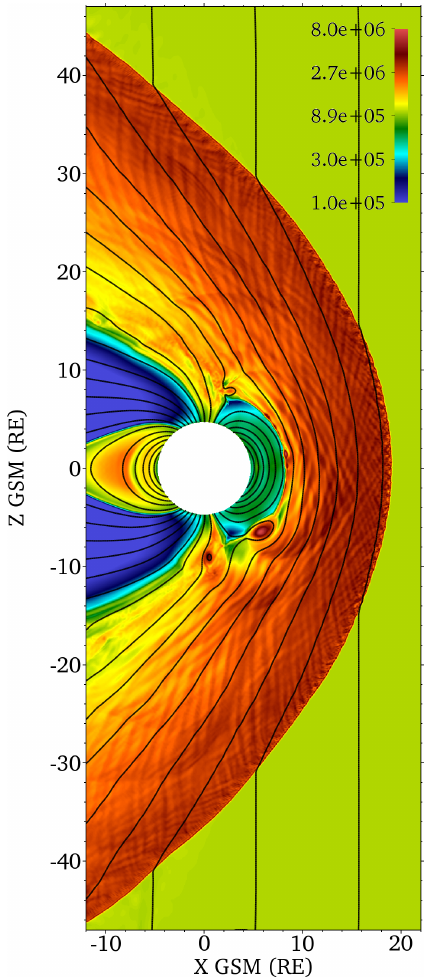
Figure 1. Colour code: plasma number density (protons m − 3 ) after 1150s of simulation time. Contour lines: magnetic field lines. A large magnetic island is prominent at ( + 6 , − 7 )R E ; another one is in the southern cusp region and a series of smaller magnetic islands is visible at the dayside magnetopause northward of the